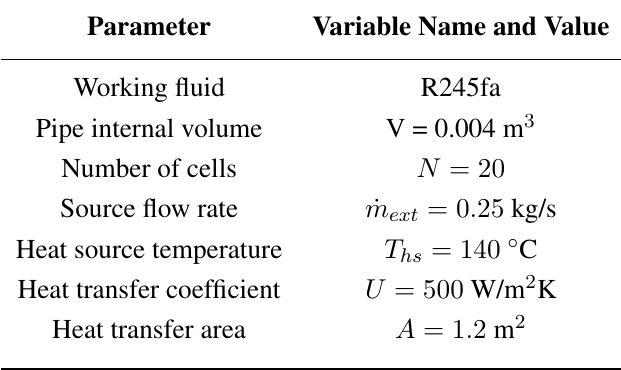
Table 1. Characteristics of the reference